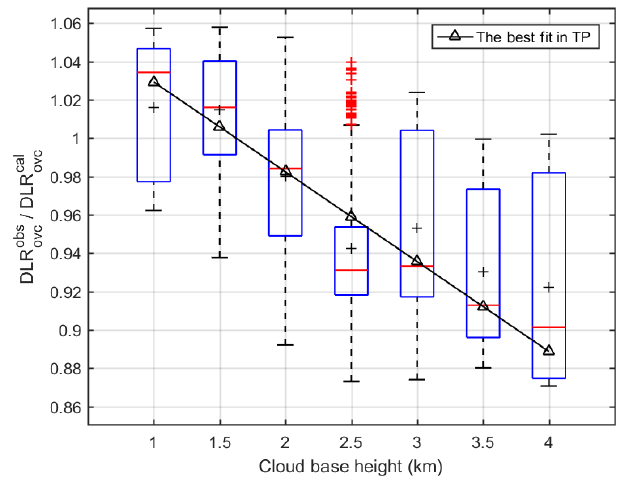
Figure 6. Distributions of the ratio of observed DLR and calculated DLR by Eq. (5) under overcast conditions against measured cloud base height are represented by box plot (the blue boxes indicate the 25th and 75th percentiles; the whiskers indicate the 5th and 95th percentiles; the middle red line is the median; the black plus sign is the mean). The black triangle line is the fitting